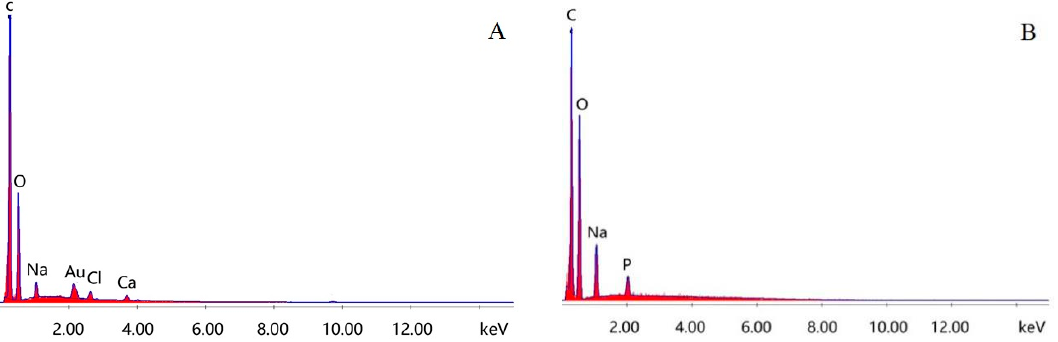
Figure 6. EDS spectra of the MCCBs ( A ) and immobilized laccase MCCBs ( B ).